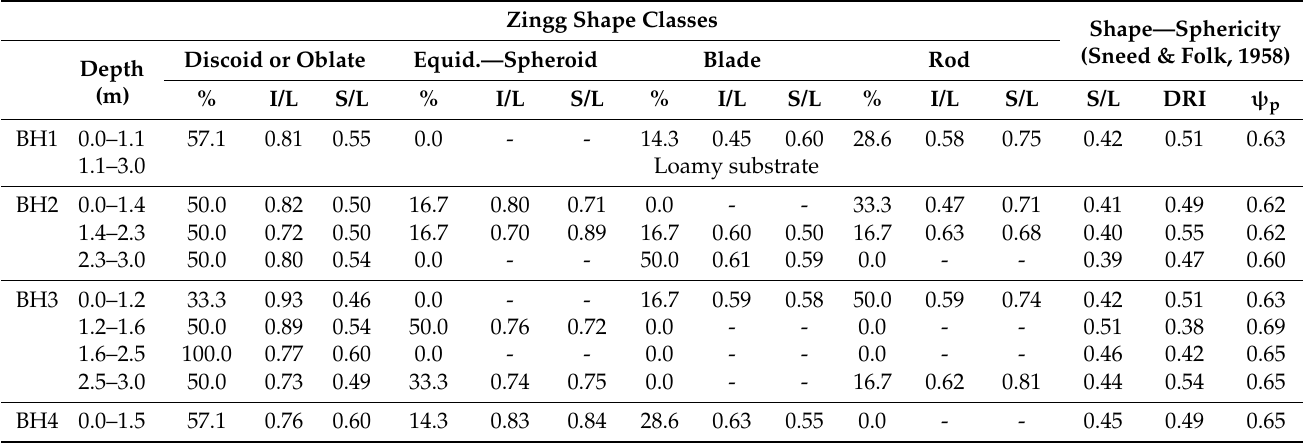
Table 3. Average values of the Zingg and the Sneed and Folk shape and sphericity indices, estimated for gravels and pebbles in borehole logs. Rambla de la Azoh í a.